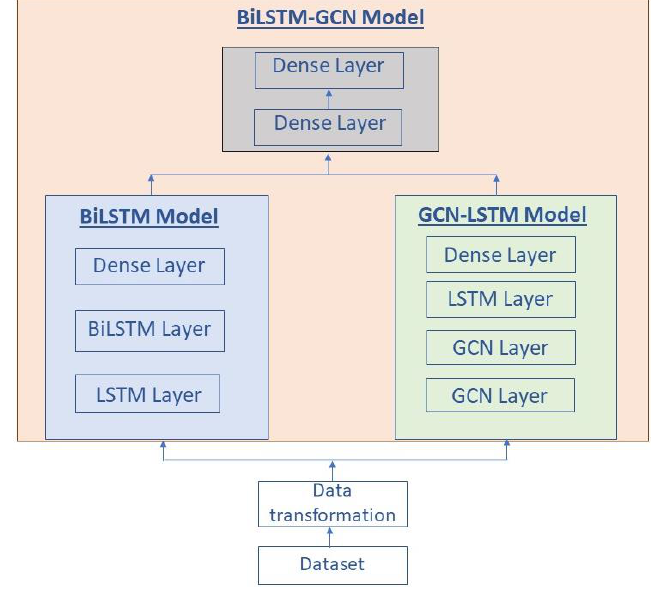
Figure 1. Proposed Network Architecture named BiLSTM-GCN.